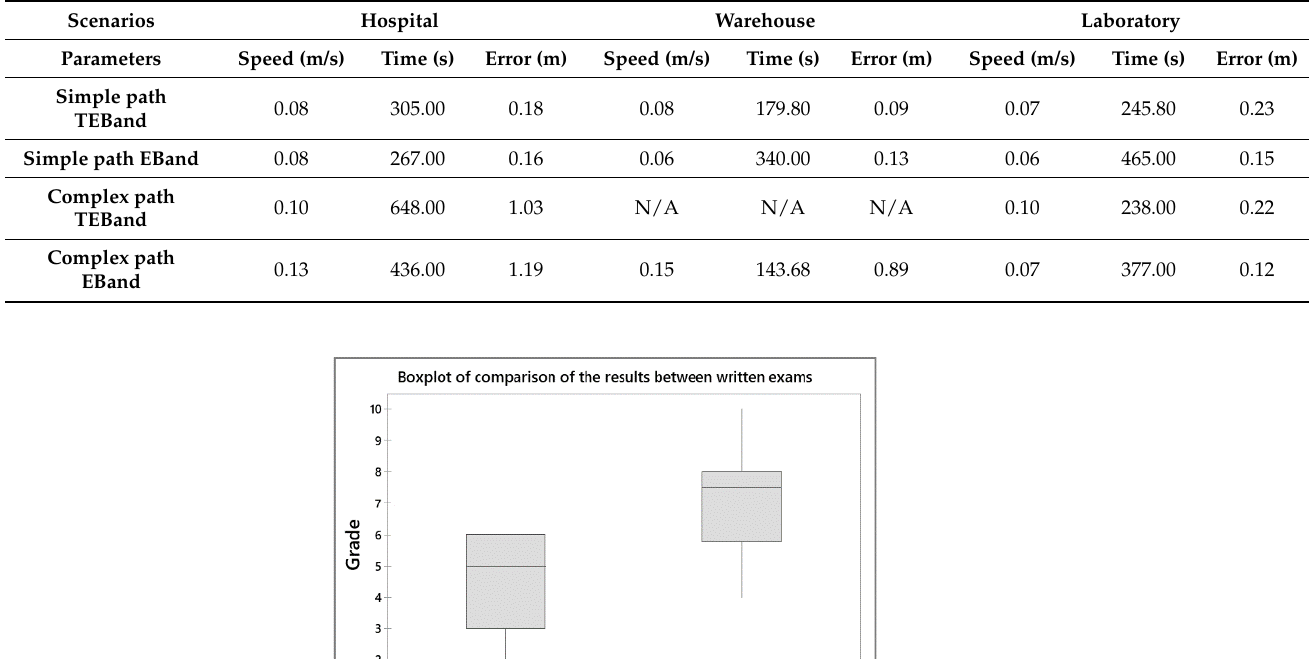
Table 3. Summary of simulation data obtained.